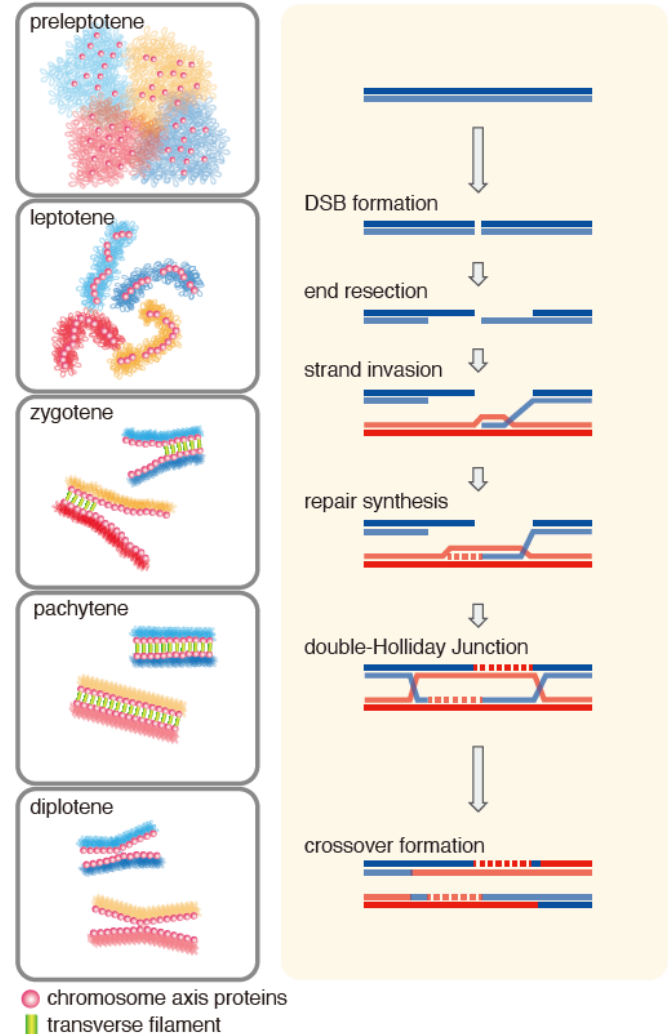
Figure 2. Progression of chromosome morphogenesis relative to the timing of steps involved in homologous recombination during meiotic prophase. For simplicity, the case with only two pairs of homologous chromosomes is shown.